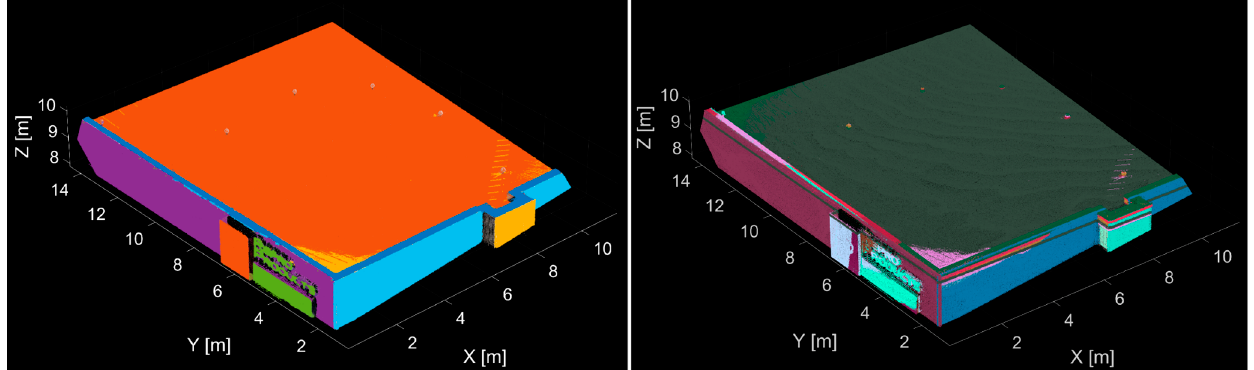
Figure 13. Result of the plane segmentation from the proposed algorithm ( left ) and the standard